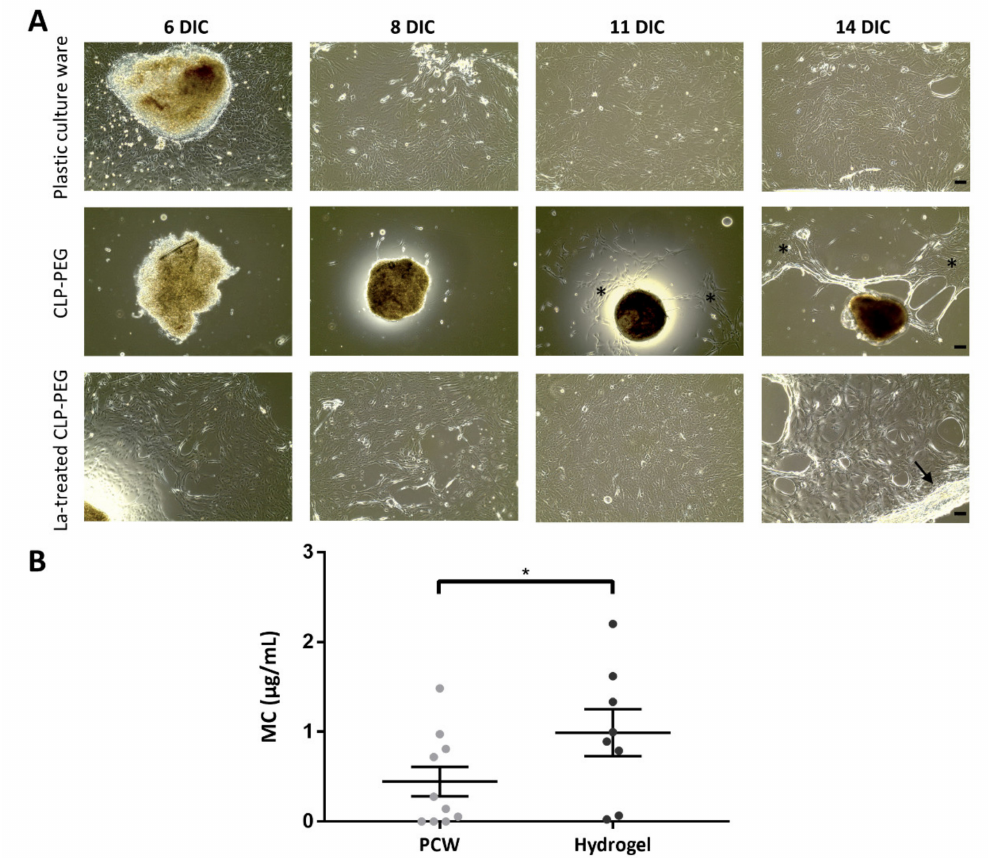
Figure 5. Comparison of conjunctival outgrowth and mucin secretion on plastic culture ware and CLP-PEG hydrogels. ( A ) Representative pictures of explant outgrowth of the same donor plated under three conditions; plastic culture ware, CLP-PEG hydrogels, and laminin-treated CLP-PEG hydrogels. Cultures were imaged at the indicated time points during the culture period. Asterisk = small outgrowth on CLP-PEG scaffolds, black arrow = reflective border, scale bar = 100 µ m. ( B ) Comparison of absolute mucin concentration of explant cultures on plastic culture ware (PCW) and laminin-treated CLP-PEG scaffolds. Both conditions had the same culture time and the growth surface of the 24-well plate (i.e., 1.9 cm 2 ) is similar to the one of the scaffold (i.e., 1.8 cm 2 ). Each bar is the mean ± SEM of technical replicates ( n = 3, grey dots for PCW cultures, black dots for hydrogel cultures) from three donors, except for one donor that has 4 and 2 replicates for PCW and laminin-treated scaffolds, respectively. Statistical significance was defined with a paired t -test. * p -value <